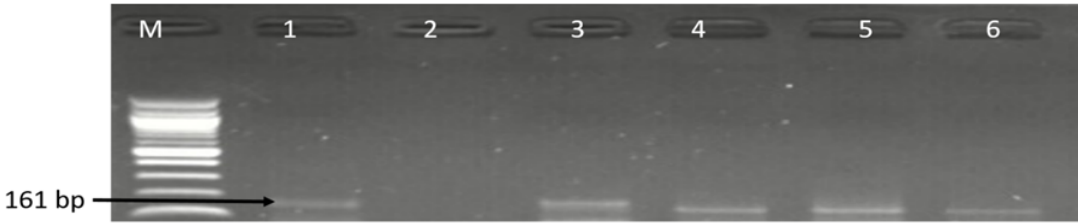
Figure 5. Gel electrophoresis image of identified C . jejuni cj0414 gene at 161 bp. Lane M: DNA ladder (100 bp), lane 1: positive control ( C. jejuni ATCC 33560), lane 3–6: some positive C . jejuni isolates.